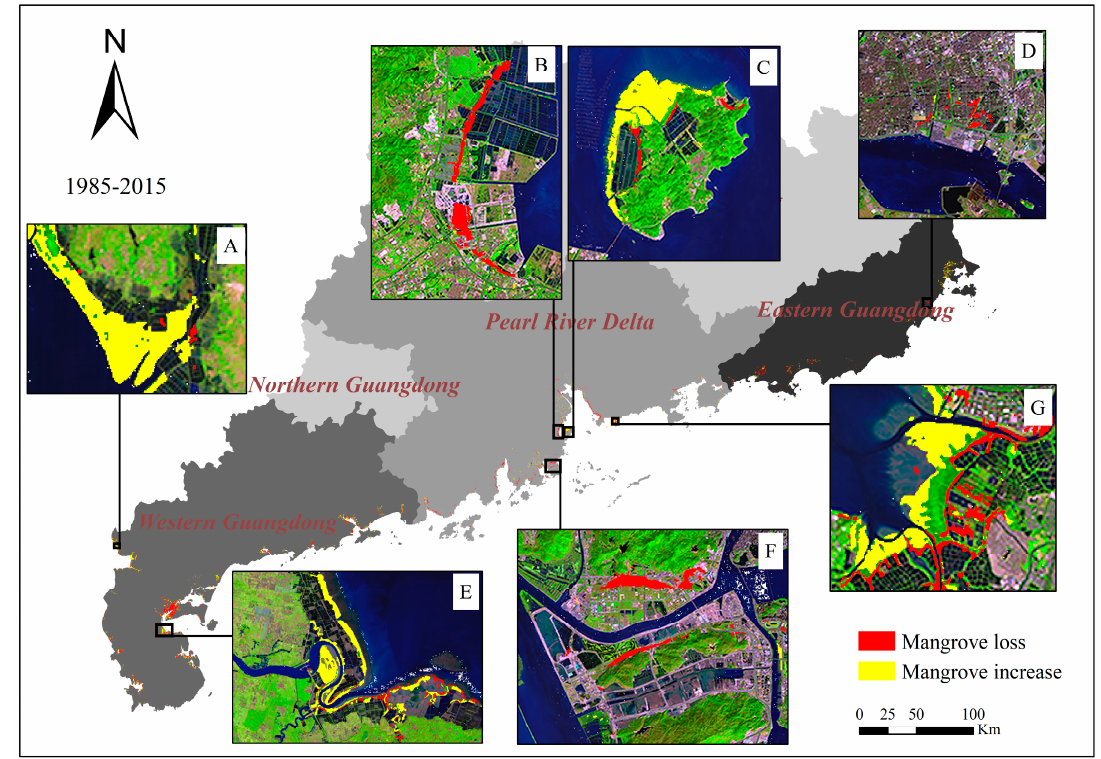
Figure 7. Spatial variation of mangrove forests in the coastal zone during the period from 1985 to 2015, with the overlay of the Landsat image collected in 2015.